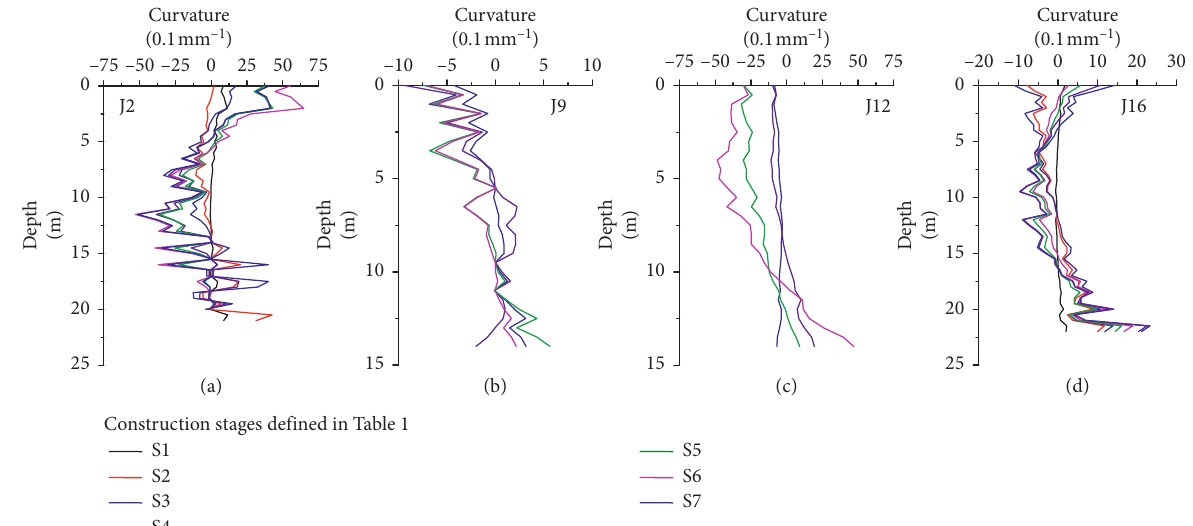
Figure 8: Directly measured bending strains at several typical construction stages in the studied case.